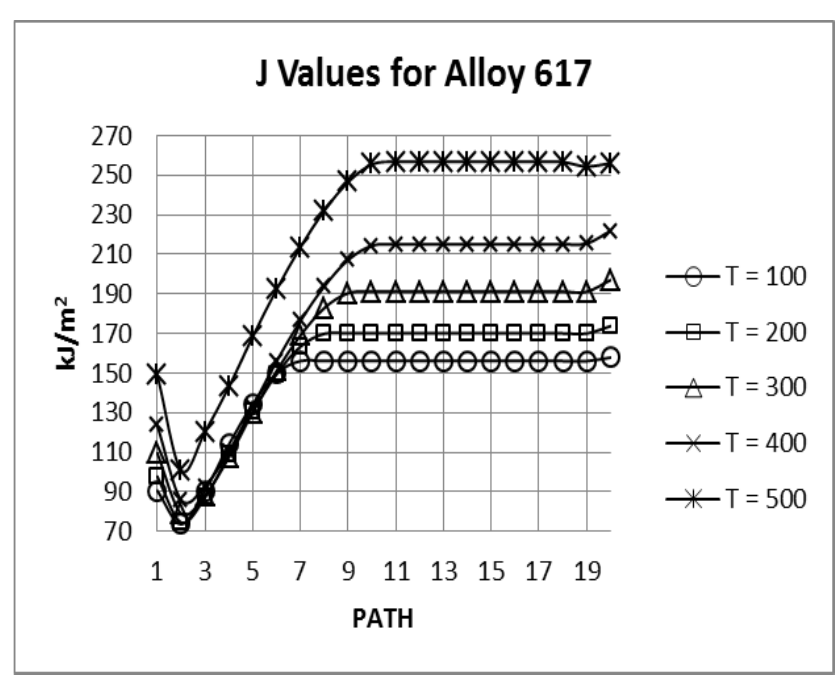
Figure 13: J Integral variation with increasing temperature for alloy